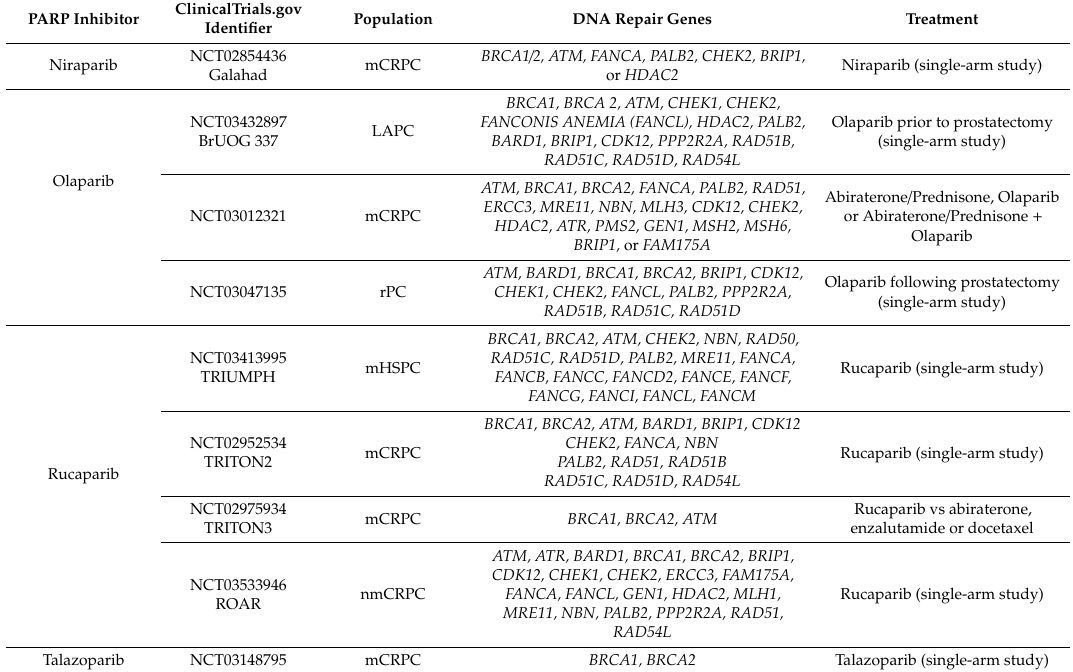
Table 2. Clinical trials of PARP inhibitors in prostate cancer with defects in DNA repair